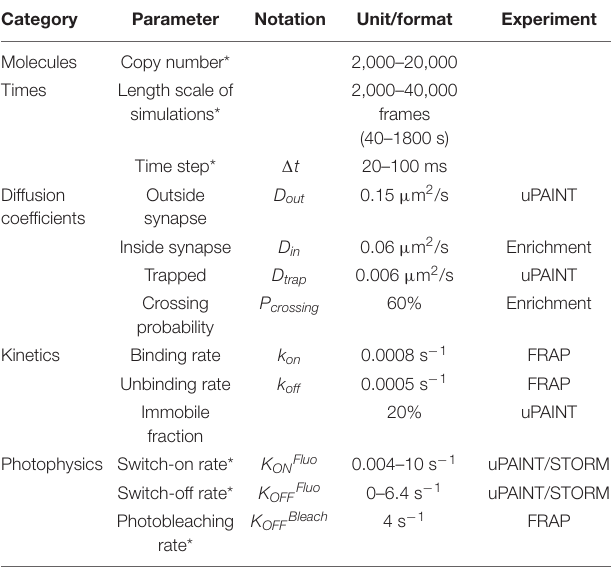
TABLE 1 | Biophysical